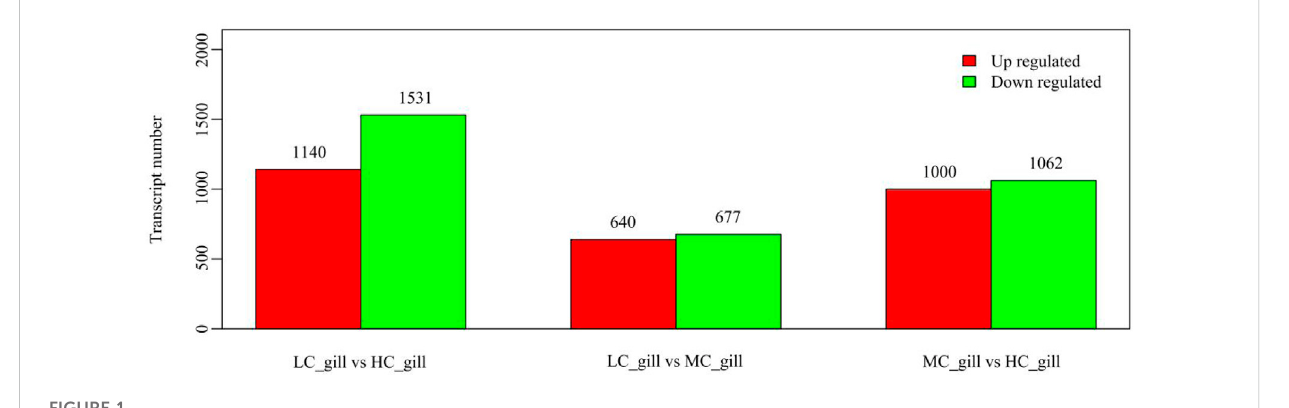
FIGURE 1 The number of differentially expressed genes in the three